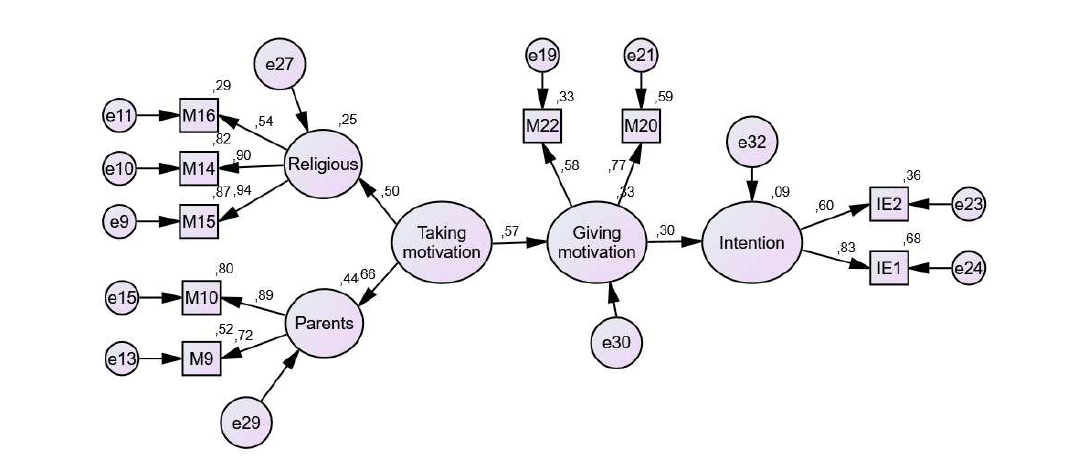
Figure 3. The structural model of the third